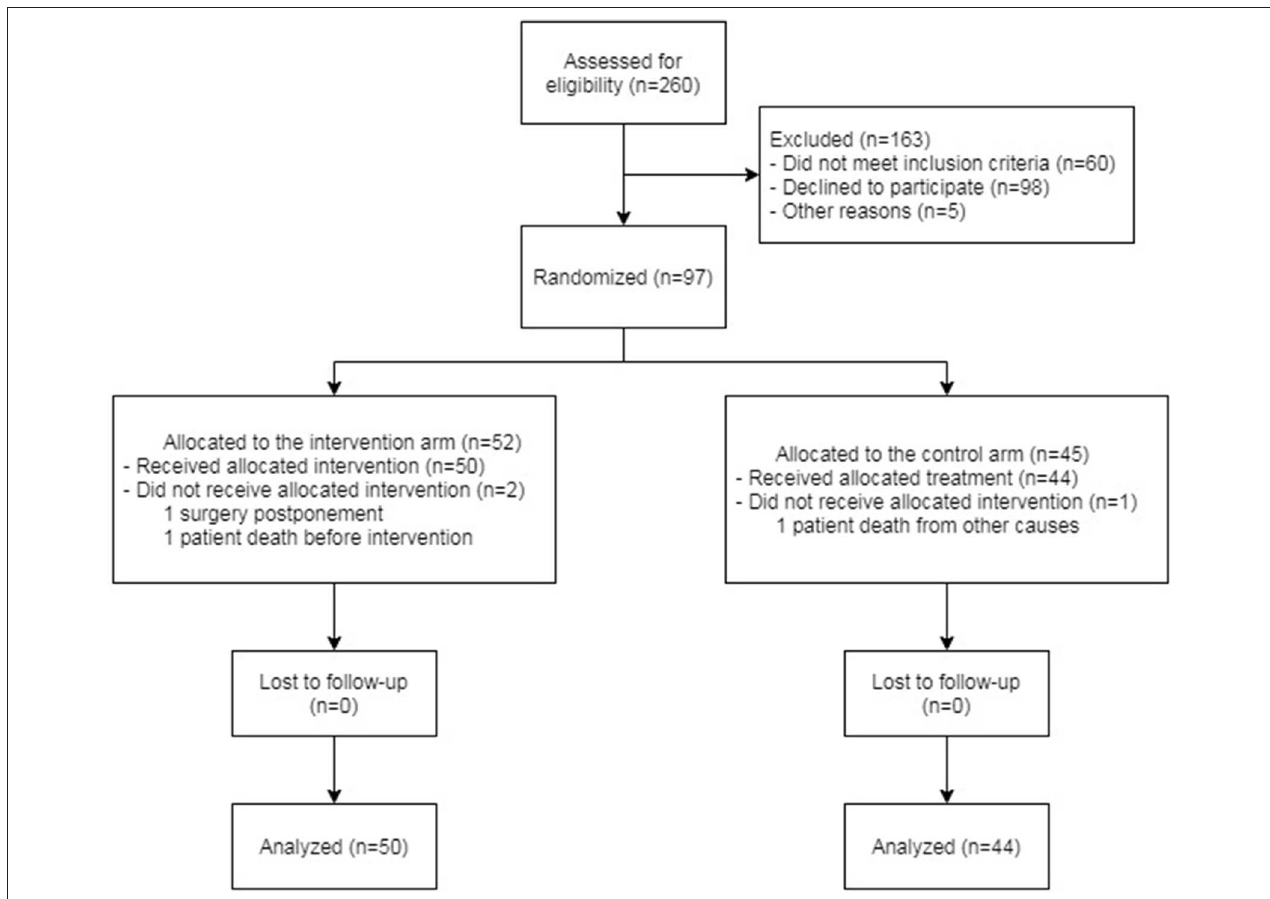
FIGURE 2 | Flow diagram of patient